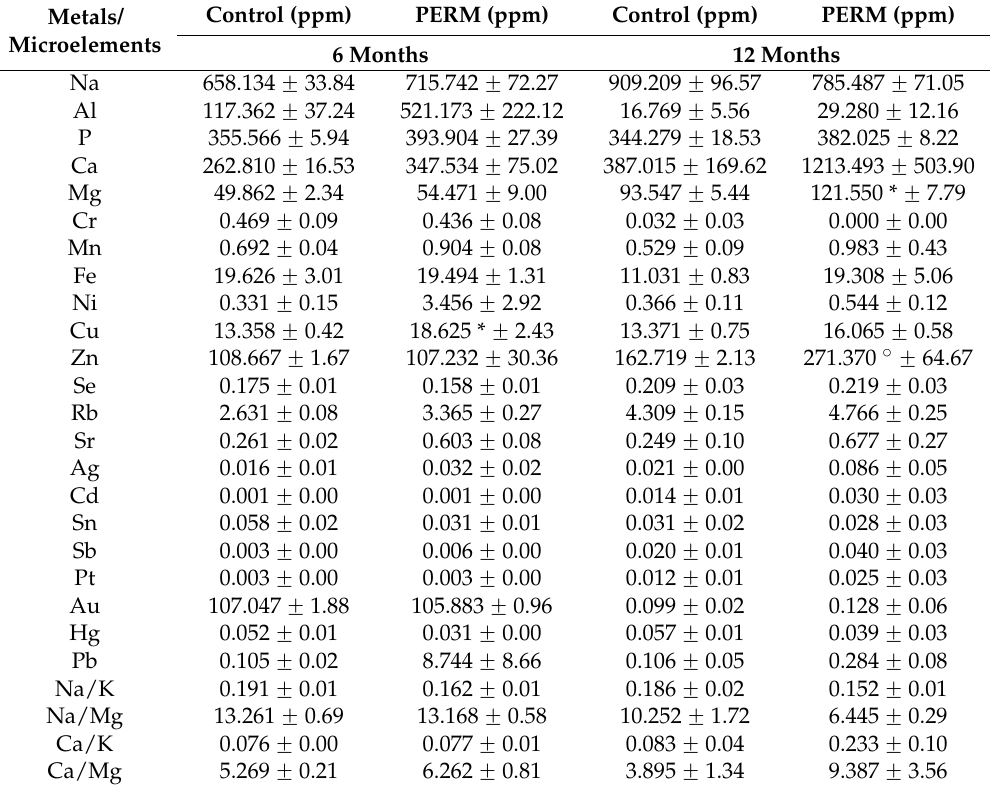
Table 2. ICP-MS analysis of the main metals and microelements contained in the neck hair of rats, exposed to Permethryn (PERM) during early life. Data are the means ˘ SEM at two time